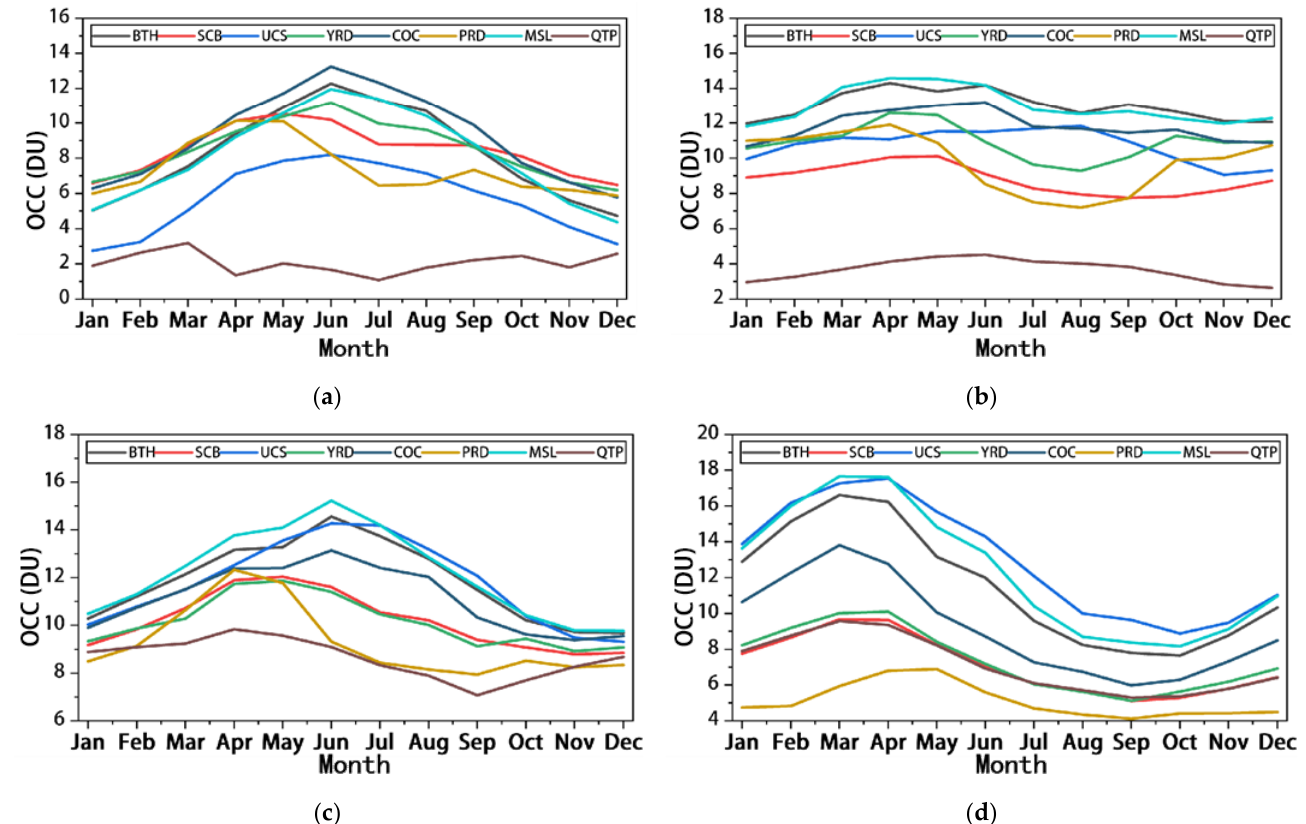
Figure 7. The monthly variation trend of OCC at different troposphere levels in China: ( a ) the monthly average variation trend of OCC at 0 – 3 km; ( b ) the monthly average variation trend of OCC at 3 – 5.8 km; ( c ) the monthly average variation trend of OCC at 5.8 – 9.6 km; and ( d ) the monthly average variation trend of OCC at 9.6 – 12.4 km.